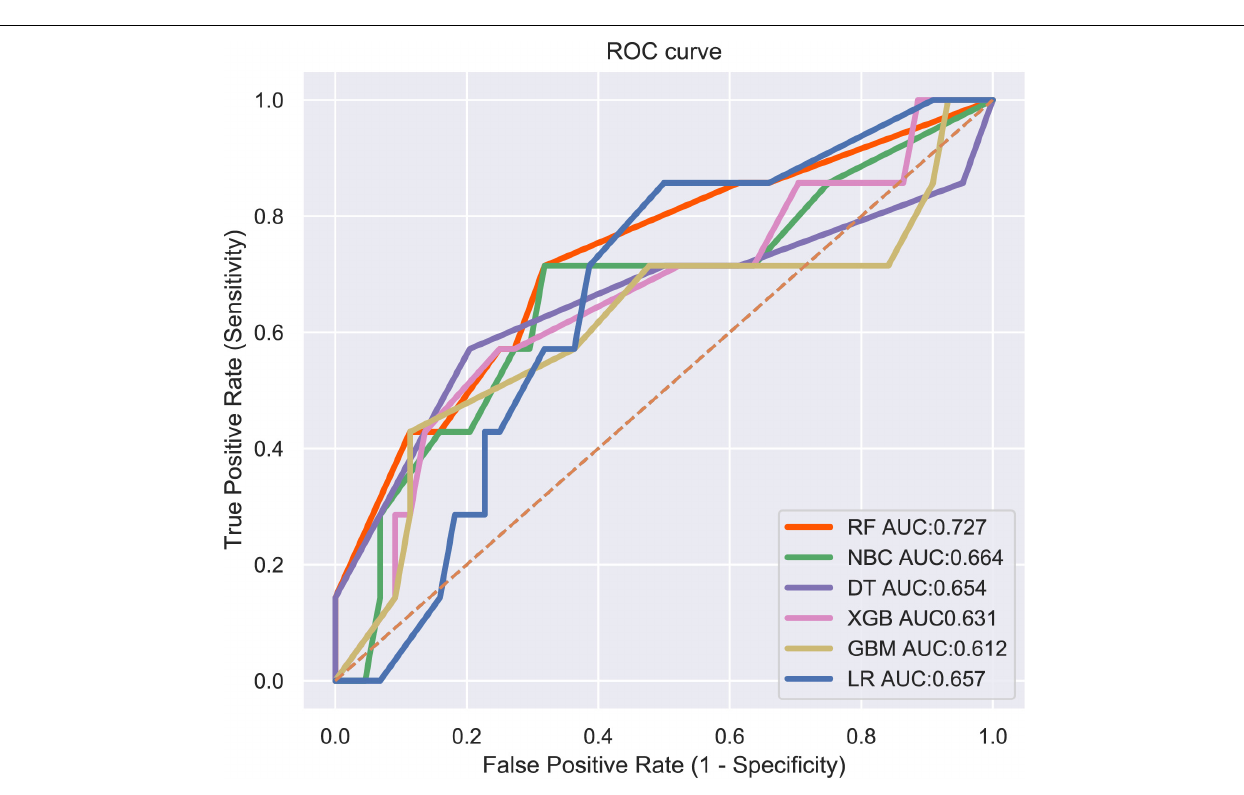
Frontiers in Medicine |